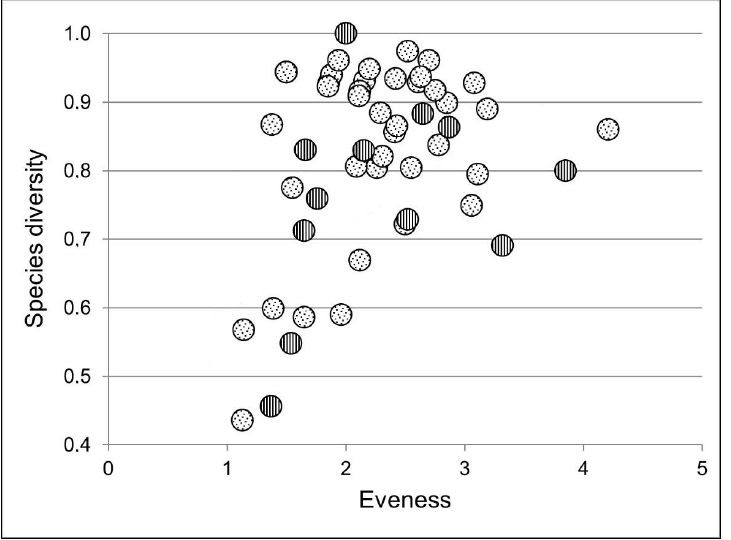
Figure 4. The relationship between species diversity and evenness for summer (light circles and straight line) and autumn (dashed circles and dotted line) communities of Rotifera in the studied springs.